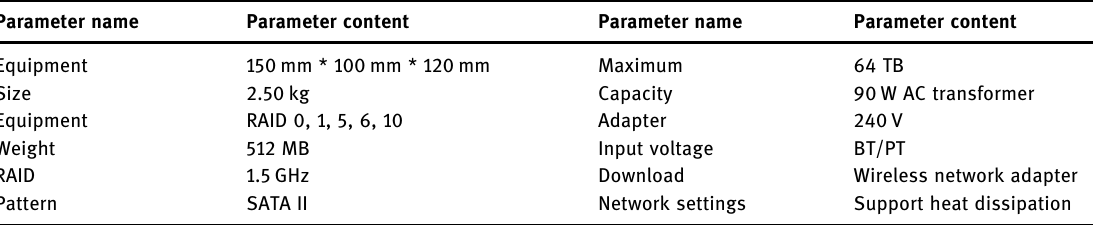
Table 1: Parameter setting of external memory